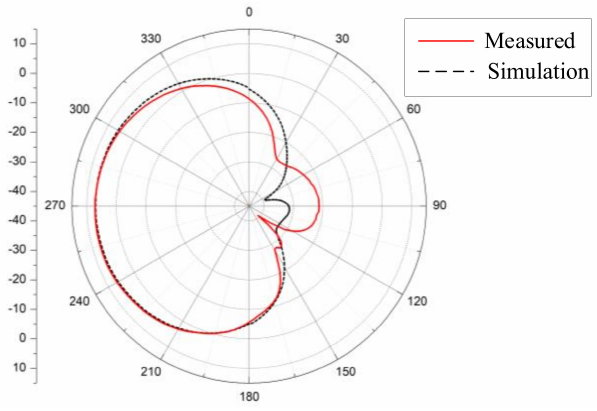
Figure 19. Transmitting antenna measured and simulated pattern.